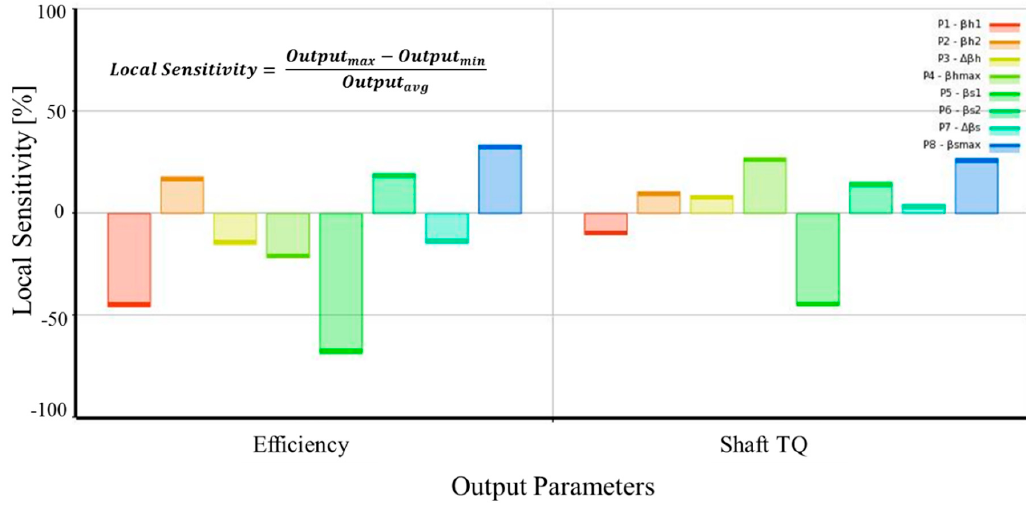
Figure 9. Local sensitivity of the design parameters for the efficiency and the shaft torque (TQ).